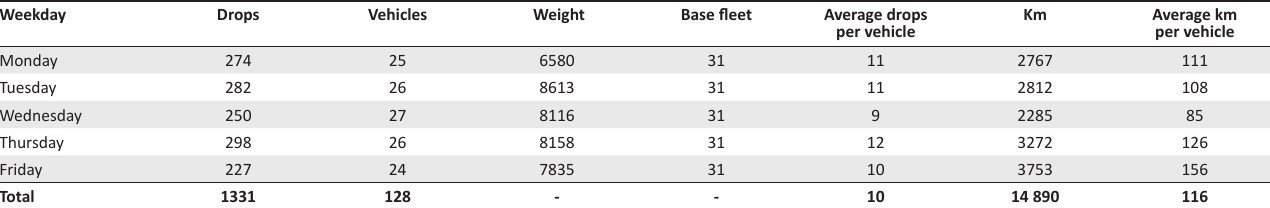
TABLE 1: Distribution centre 1 plan case study